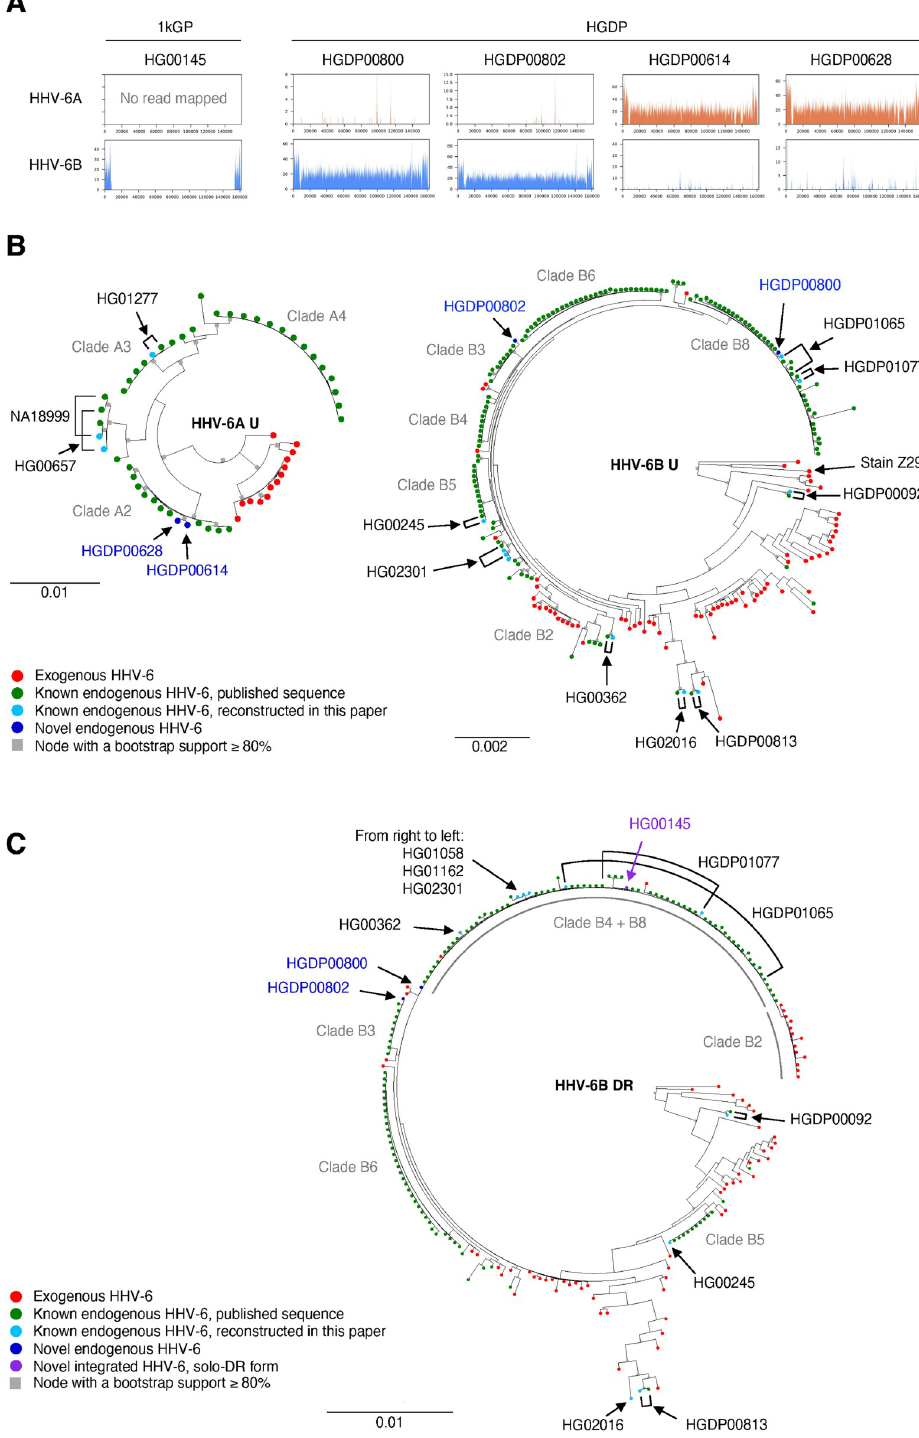
Fig 3. Detection and phylogenetic analysis of endogenous HHV-6. A. Depth of reads mapping to HHV-6 in the 5 WGS datasets from 1kGP and HGDP. B. Phylogenetic trees inferred from U regions of HHV-6A and B. The publicly available sequences of endogenous and exogenous HHV-6 as well as ones reconstructed in the present study were used. C. Phylogenetic tree inferred from DR regions of HHV-6B. The publicly available sequences of endogenous and exogenous HHV-6B, as well as ones reconstructed in the present study, were used. B, C. Clade names defined in the phylogenetic analysis in Aswad et al . are shown.